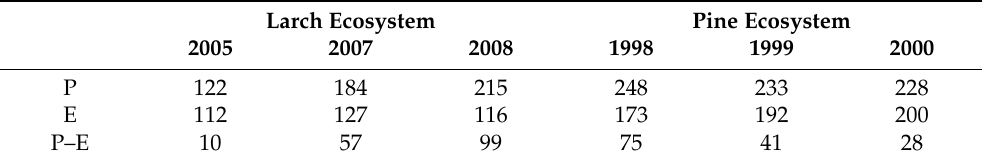
Table 1. Water balance: precipitation (P), evaporation (E), and (P-E) for the growing season (May– September) in the Gmelin larch and pine